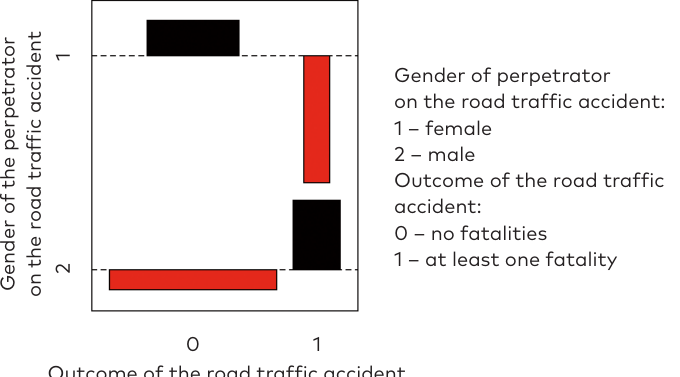
Figure 1. Association plot for categorical variables based on the gender